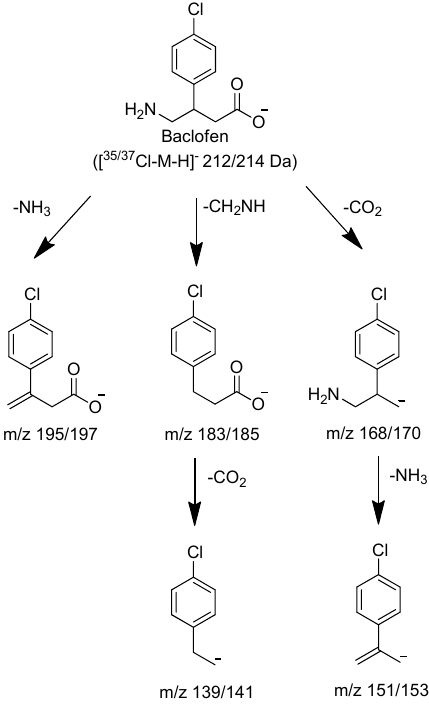
Figure 3. Proposed characteristic (-)CID-MS/MS fragmentations for